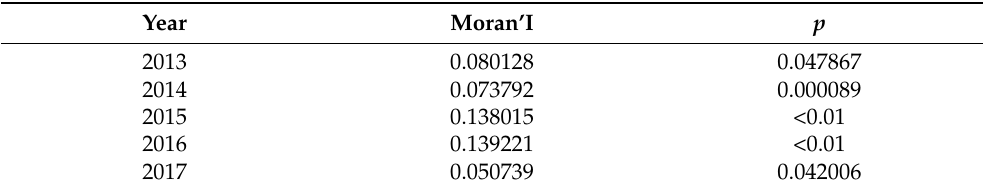
Table 1. Results of global spatial autocorrelation analysis and significance test of H7N9 outbreaks in China from 2013 to 2017.